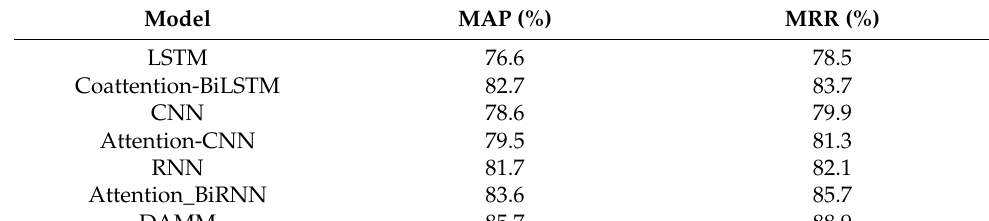
Table 3. Effects of different models on rice-related answer selection dataset.